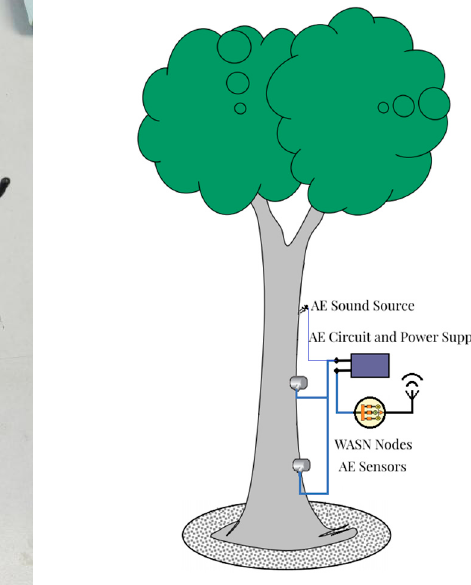
Figure 2. Framework of wireless AE node composition.